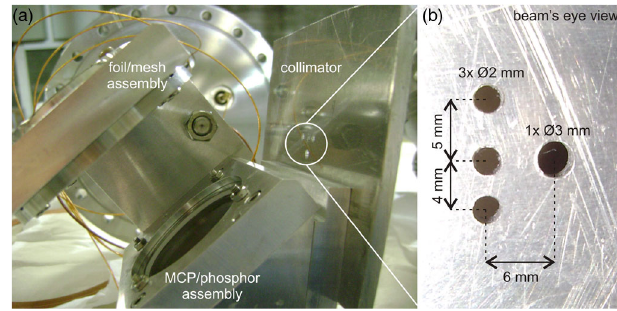
FIG. 12. Secondary emission monitor (a) and the collimator (b) as installed at INFN-LNS.